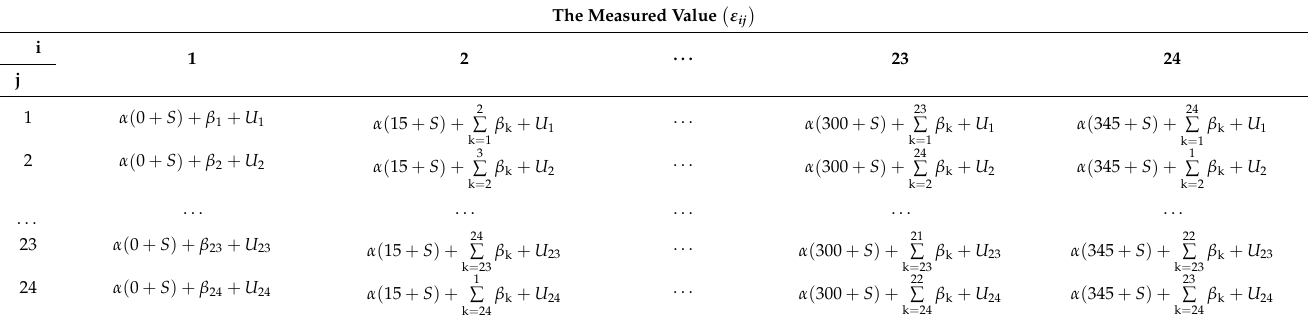
Table 1. Shift-angle method for rotary